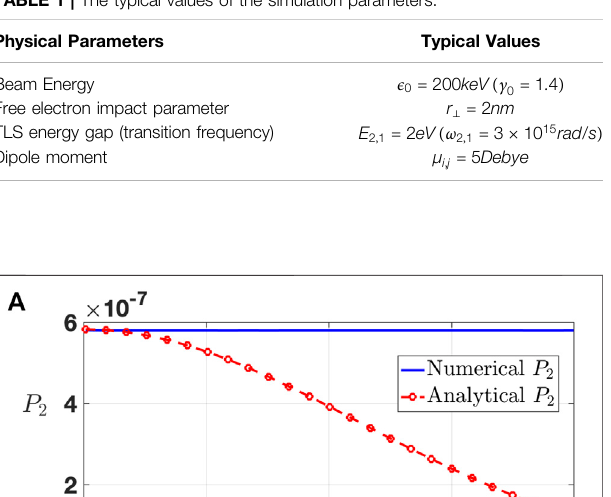
TABLE 1 | The typical values of the simulation parameters. Physical Parameters